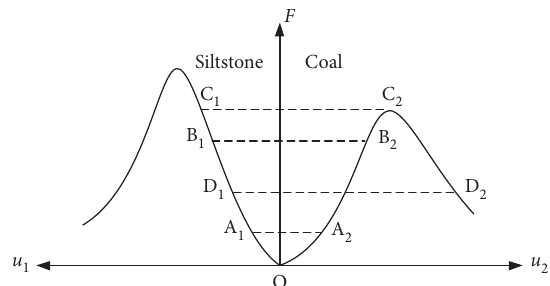
Figure 7: Load-displacement curve of coal specimen and